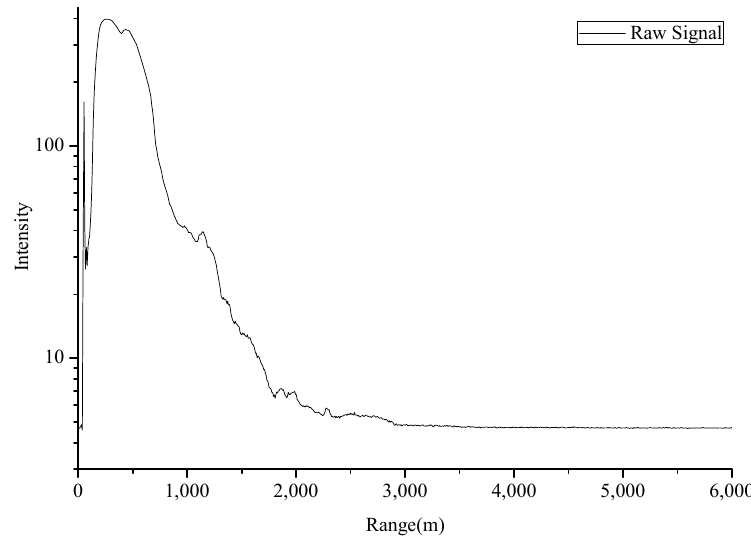
Figure 10. Lidar signal after the subtraction of background noise (30 July 2016).